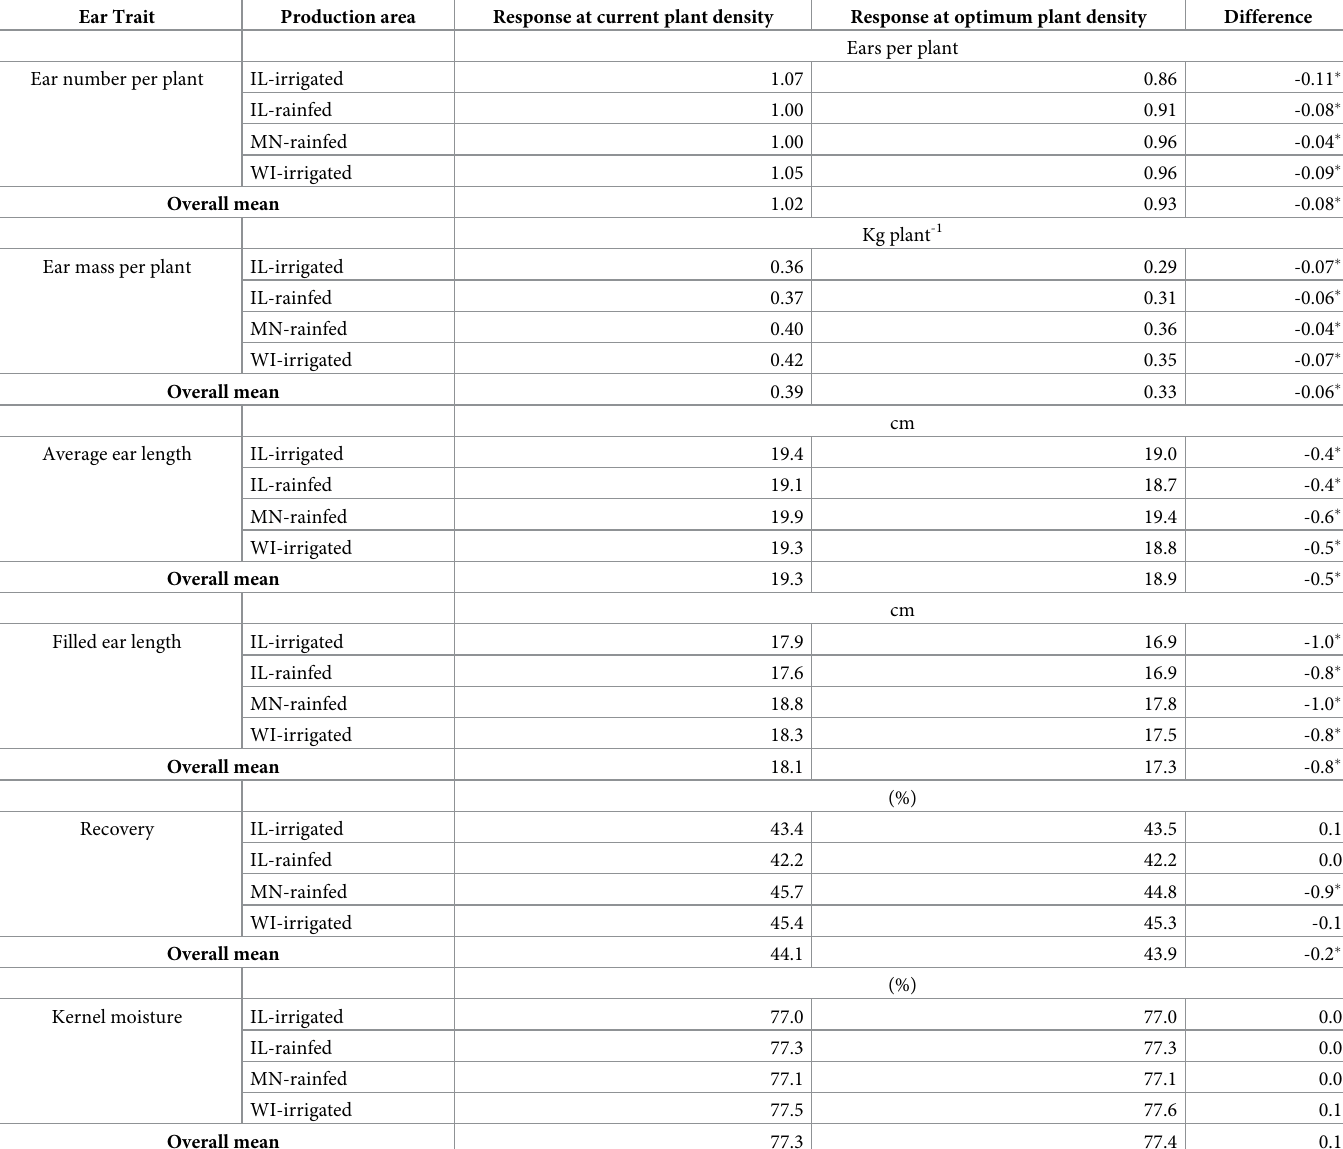
Table 4. Effect of a crowding stress tolerant hybrid on ear traits when shifting from current plant density to plant density optimized for maximum gross profit mar- gin ($ ha -1 ) across different production areas. Ear